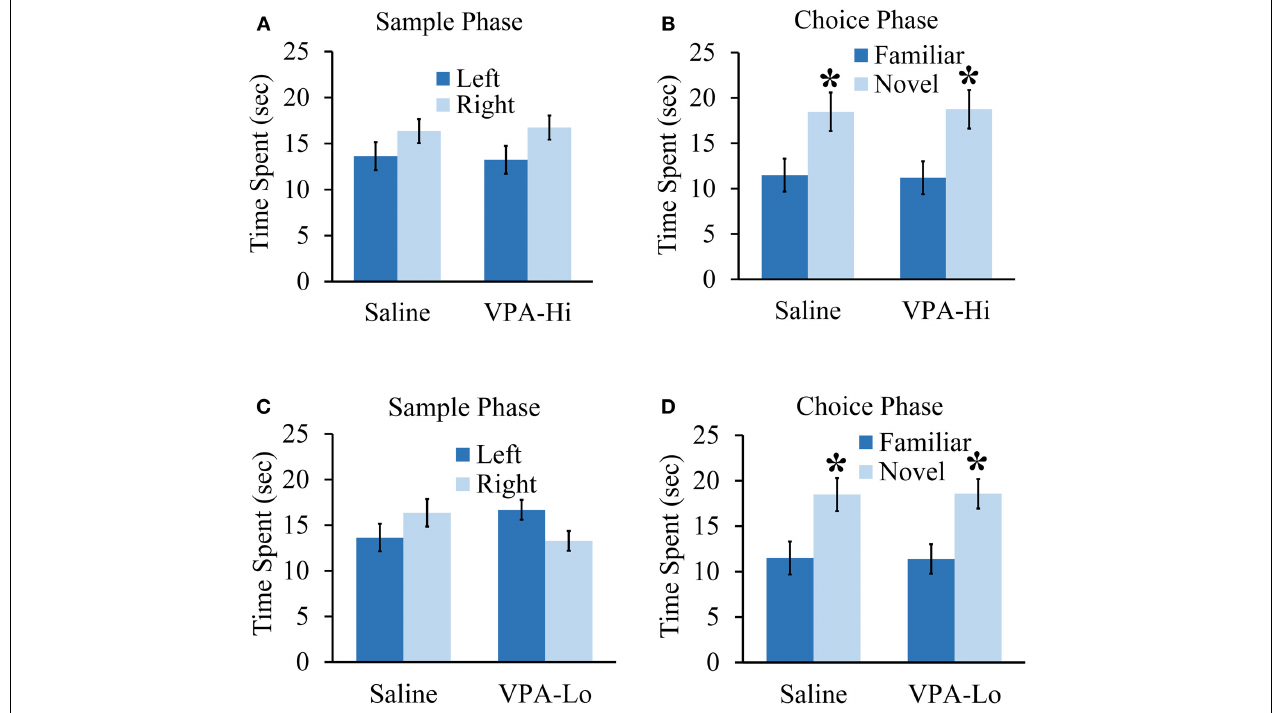
FIGURE 5 | Progeny from VPA exposed dams exhibit normal objection recognition memory. (A) Progeny from VPA-Hi and saline exposed dams spent equal time with the familiar object during the sample phase of an object recognition test (saline = 10, VPA-Hi = 8). (B) VPA-Hi and saline animals spent more time than chance with a novel object during the choice phase of an object recognition test, indicating normal retention of object